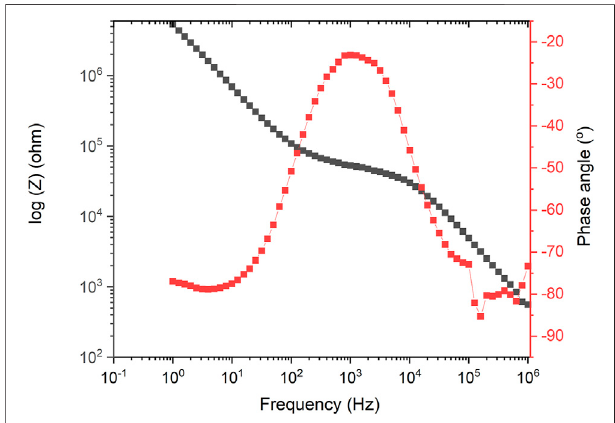
FIGURE 2 | Bode plot containing information of phase angle and impedance as a function of